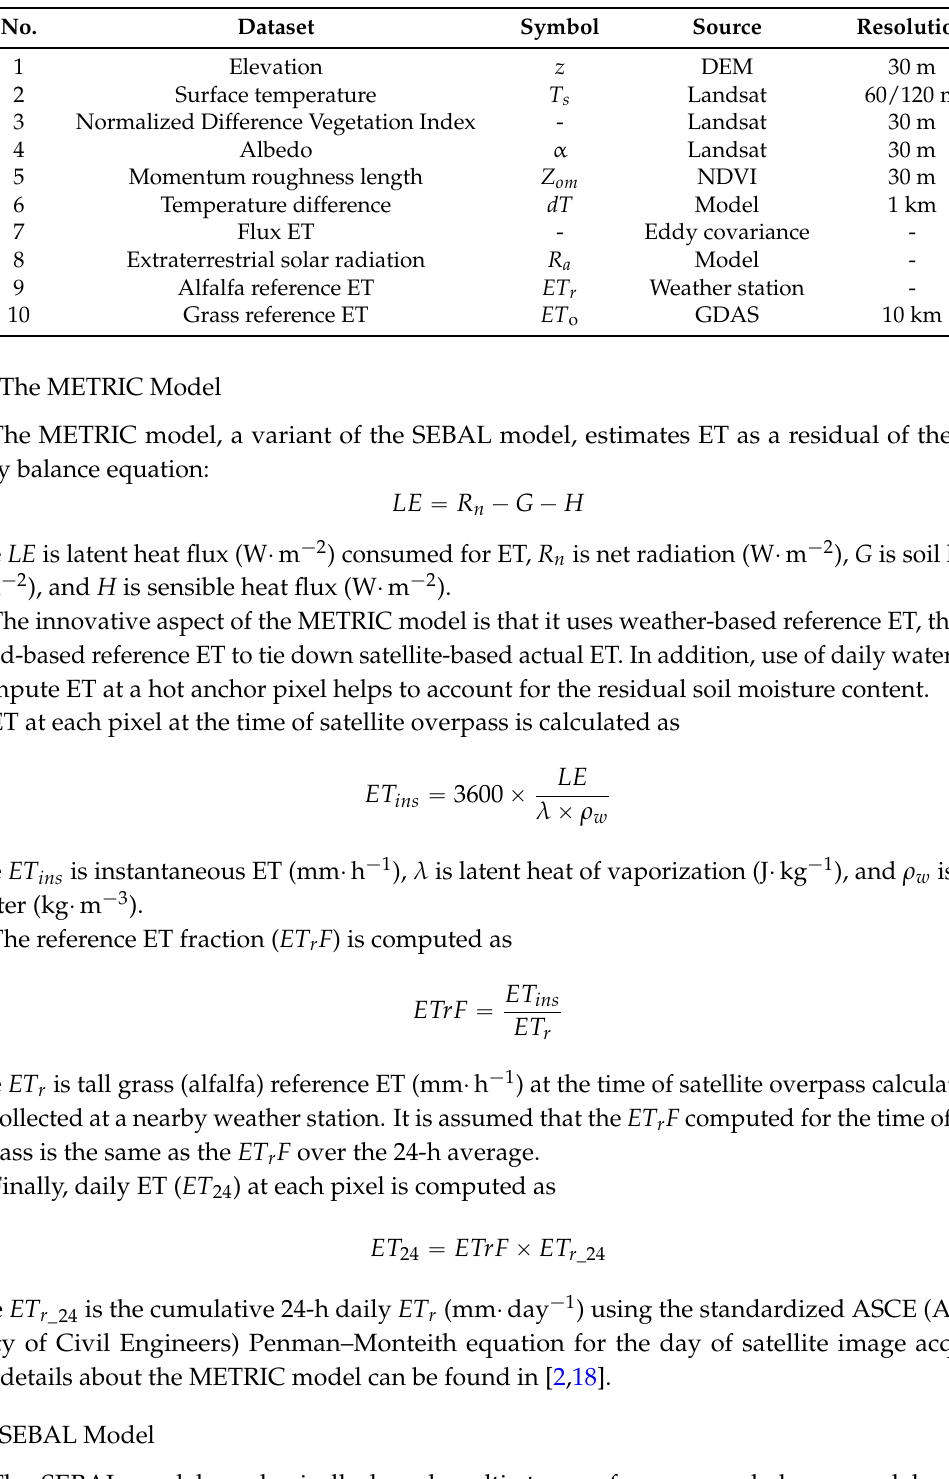
Table 1. Overview of datasets used in this